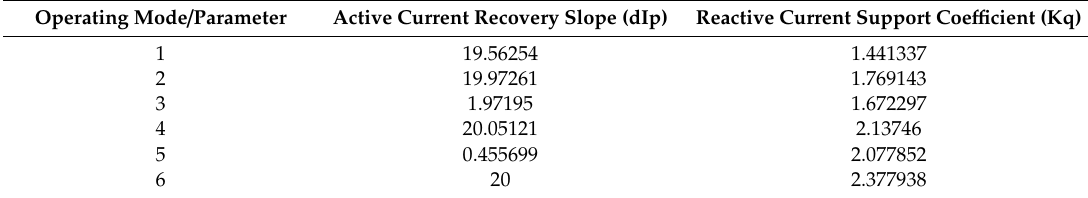
Table 4. Preliminary result of parameter identification.